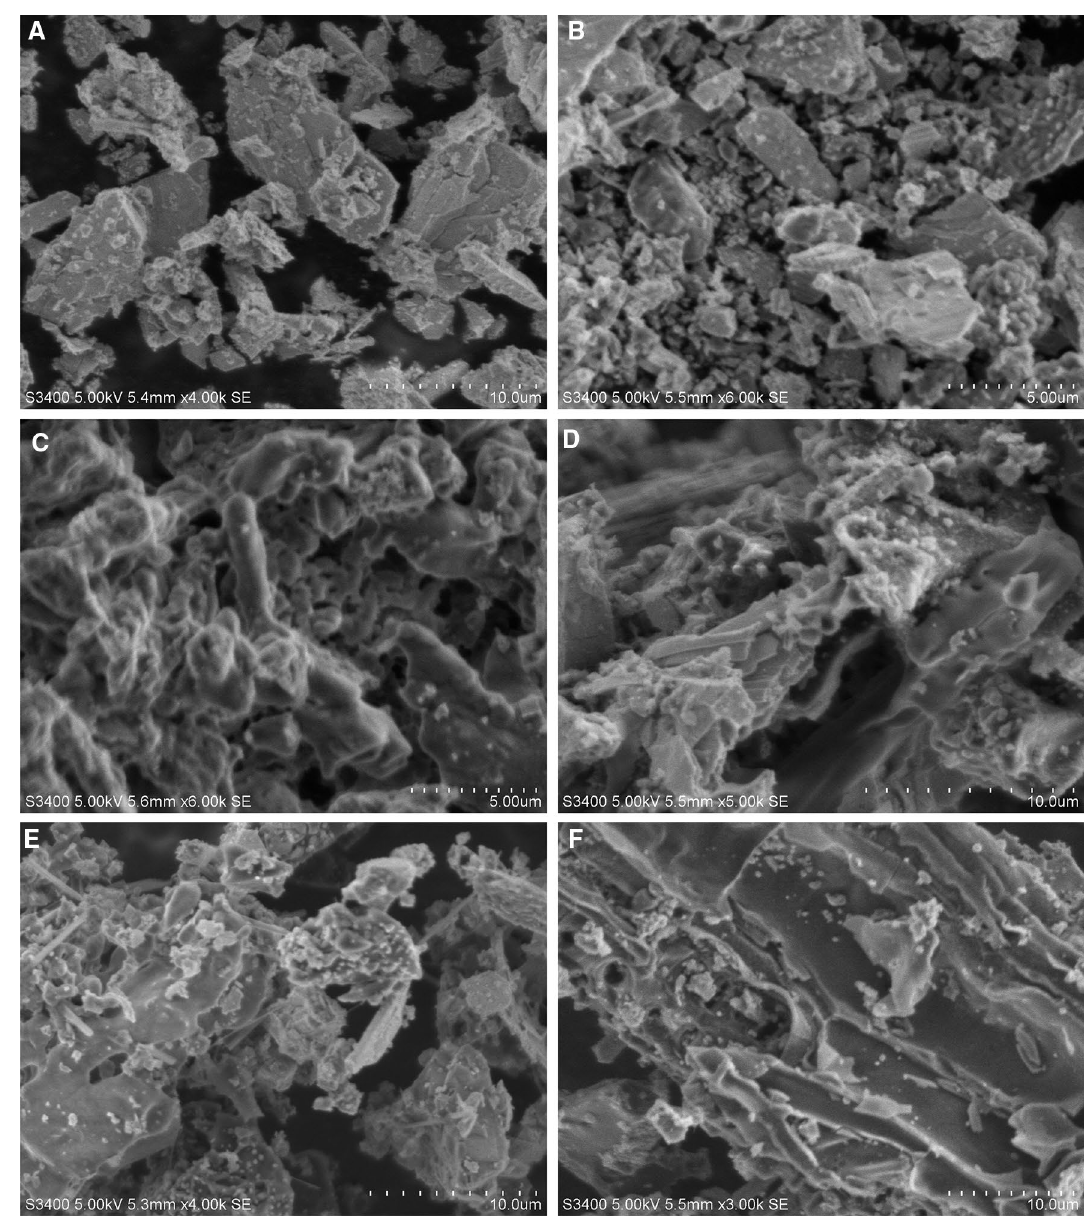
Fig. 5 SEM images of CeO Table 2 BET surface area and particle size distribution of CeO